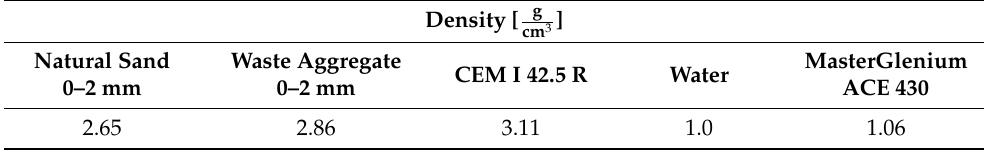
Table 2. Density of mix